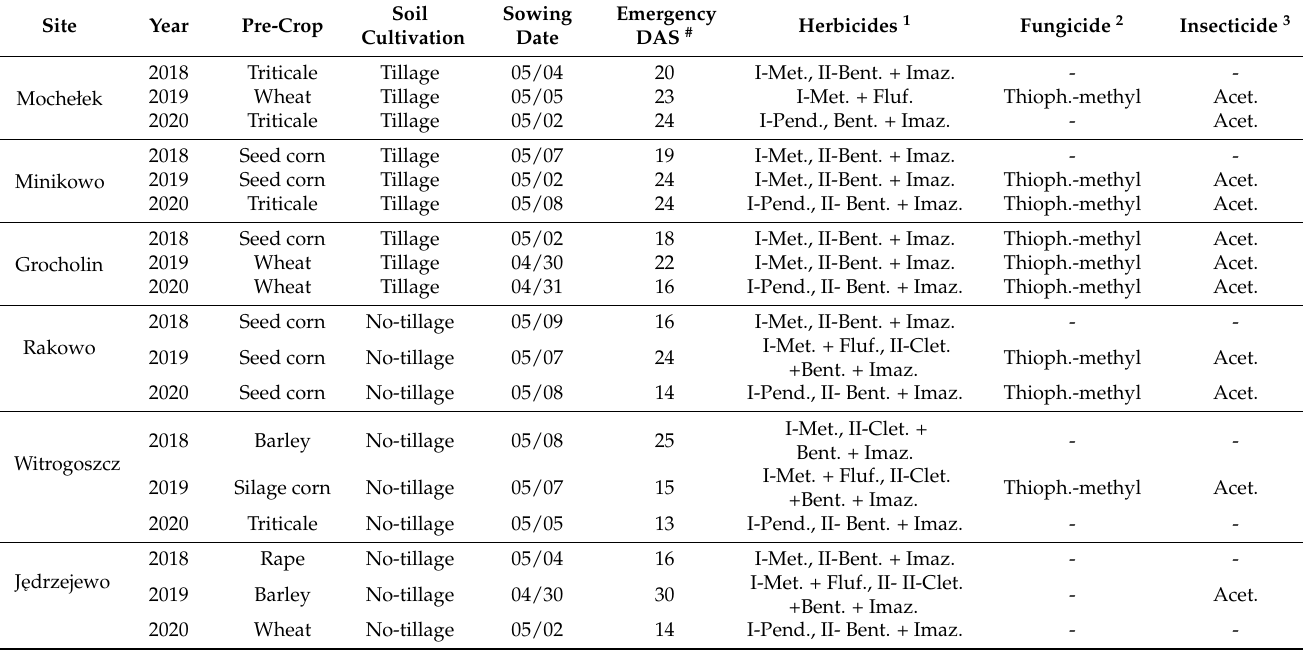
Table 3. Agrotechnical characteristics in the sites and years of the